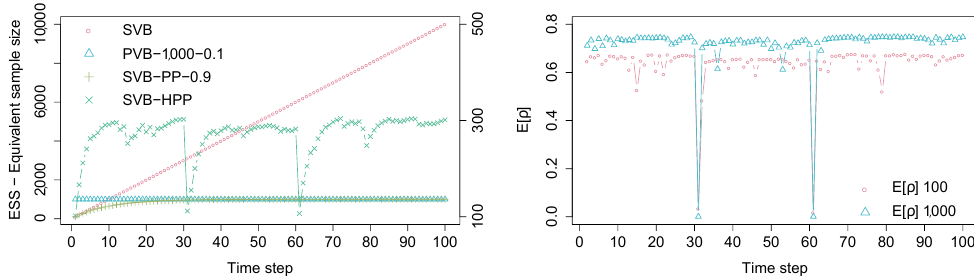
Figure 6. The results for the beta-binomial model artificial data set. Left panel: The equivalent sample size of the posterior, ESS post , t , for the different methods; the values for SVB-HPP are shown on the right y -axis. Right panel: The expected values of ρ t , E q [ ρ t ] , for batches of size 100 and 1000,